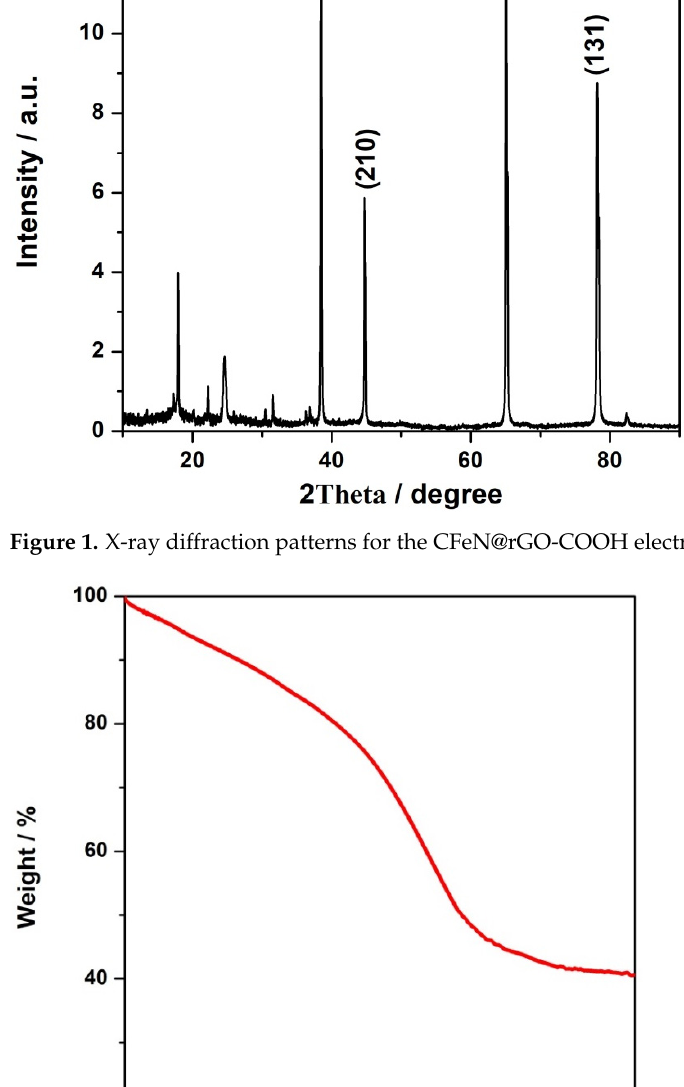
Figure 1. X-ray diffraction patterns for the CFeN@rGO-COOH electrocatalysts.